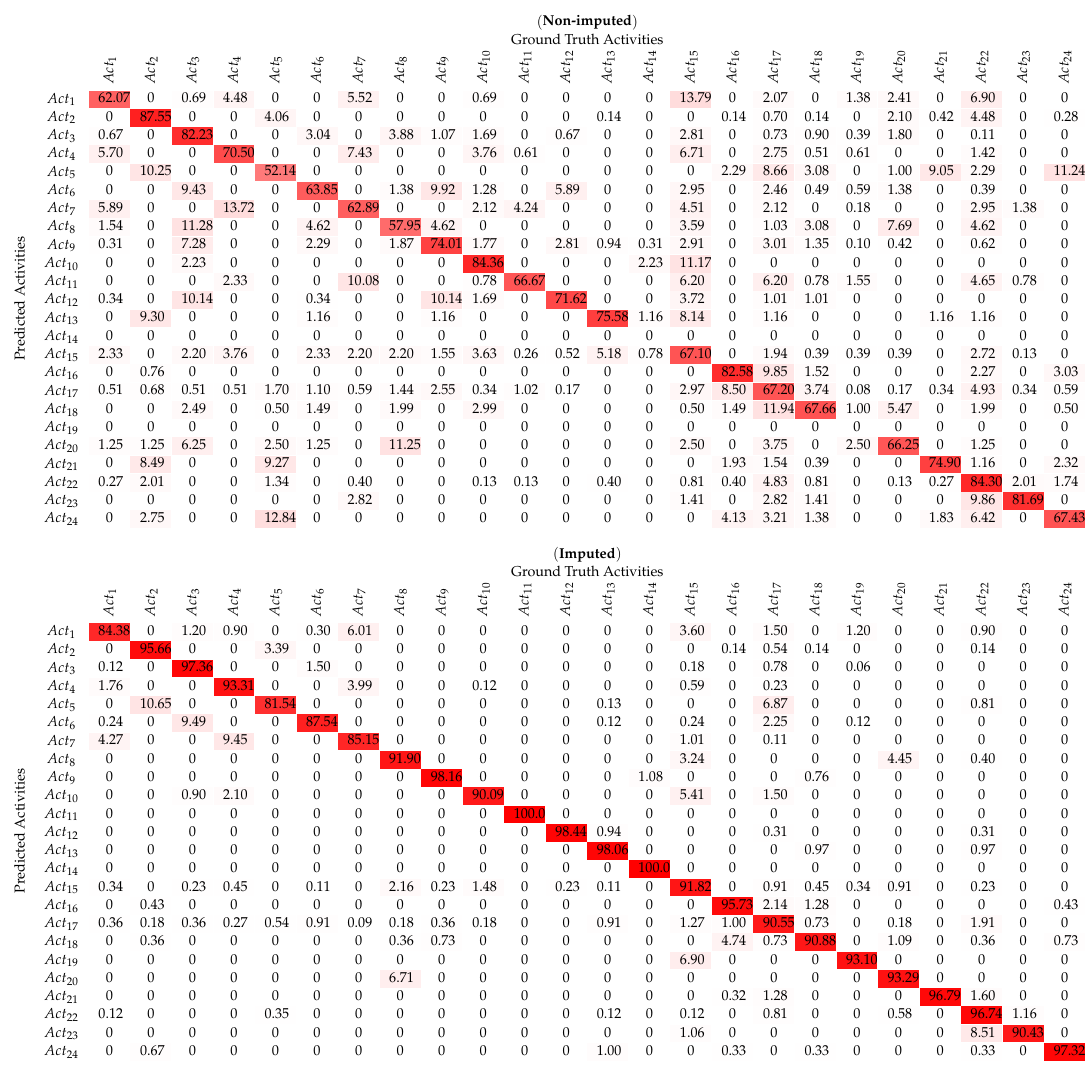
Table 2. Confusion matrix for per-class HAR using non-imputed & imputed UCamI